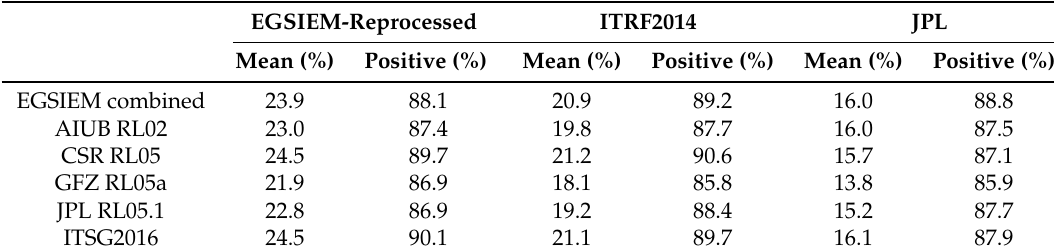
Figure 3. WRMS reduction at the full signal over 928 GNSS stations using the ITRF2014 residuals. GRACE gravity solutions up to their full spectrum are used to compute the displacements. Table 1. Mean and positive Weighted Root-Mean-Square (WRMS) reductions between six Gravity Recovery and Climate Experiment (GRACE) products and three Global Navigation Satellite System (GNSS) datasets at the full signal level. Note that the table cannot serve as comparison among the three GNSS datasets as different numbers of stations are